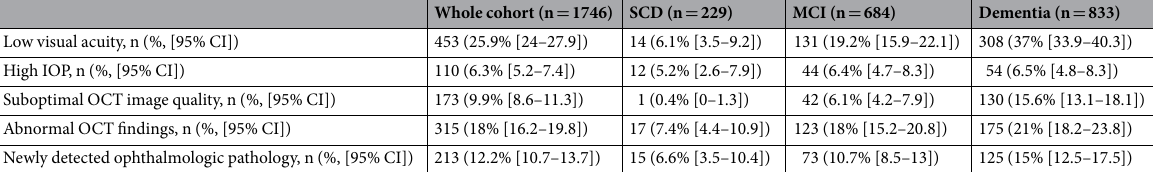
Table 3. Ophthalmological exam and OCT findings of the study cohort. CI = confidence interval; IOP = intraocular pressure; MCI = mild cognitive impairment; OCT = optical coherence tomography; SCD = subjective cognitive decline.